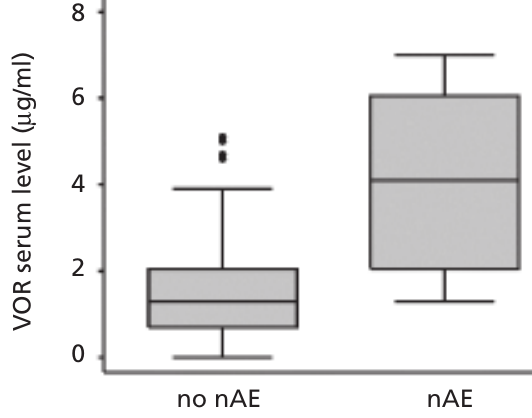
7 m g/mL (median: 1.55 m g/mL), and from 0.1